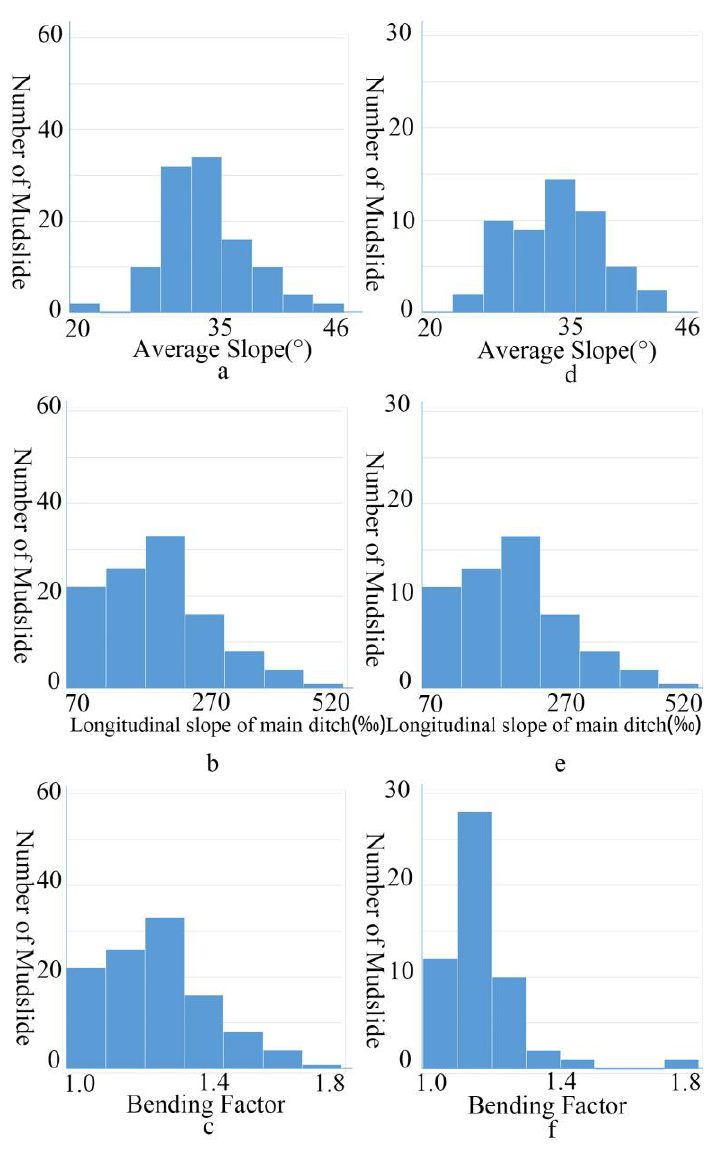
Figure 19. Average slope, longitudial slope of main ditch, and bending factor information of 110 debris flows in Beijing (Panel a – c in the left side). Average slope, longitudial slope of main ditch, and bending factor information of 53 debris flows in the coal mining area (Panel d – f in the right side).